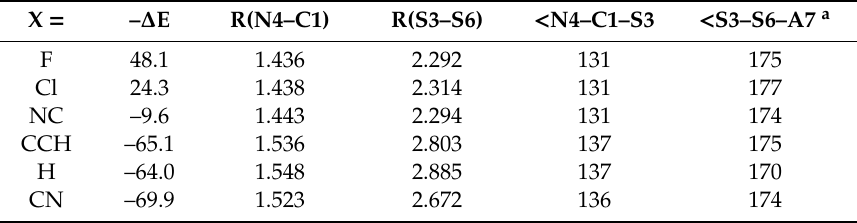
Table 4. Binding energies (– ∆ E, kJ · mol –1 ), N–C and S–S distances (R, Å), and N–C–S and S–S–A angles ( < , o ) for molecules